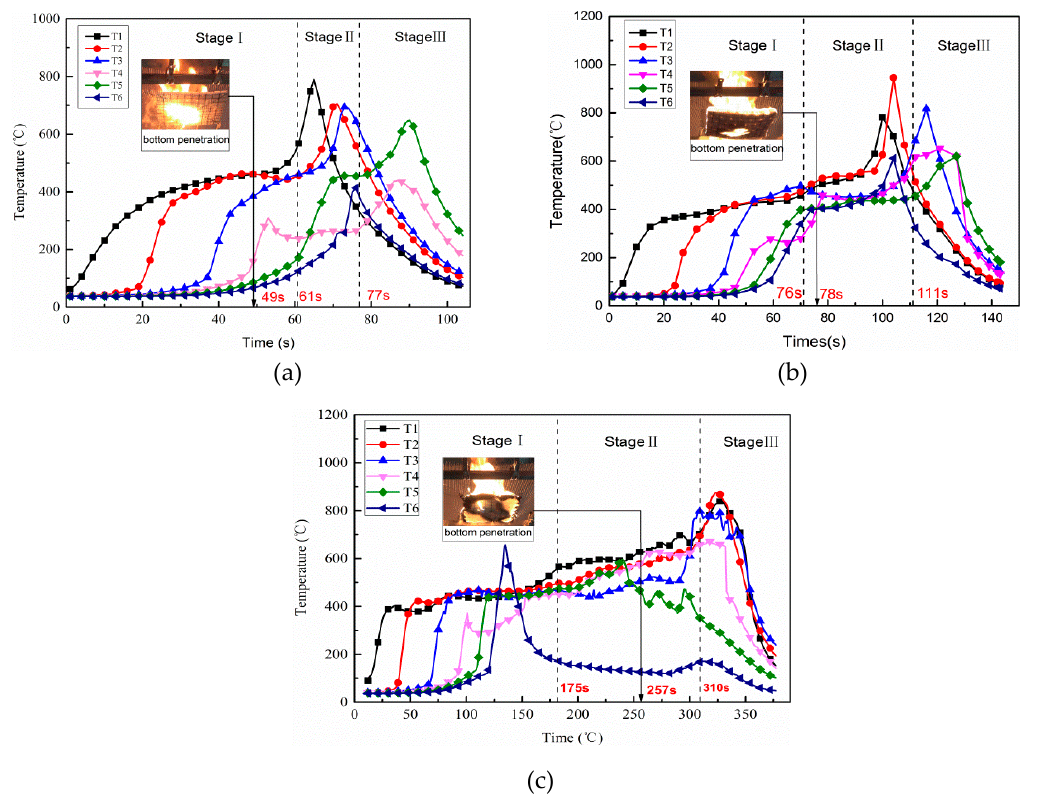
Figure 9. Surface temperature field changes of natural rubber latex foam: ( a ) 1cm; ( b ) 2 cm; ( c ) 5 cm.